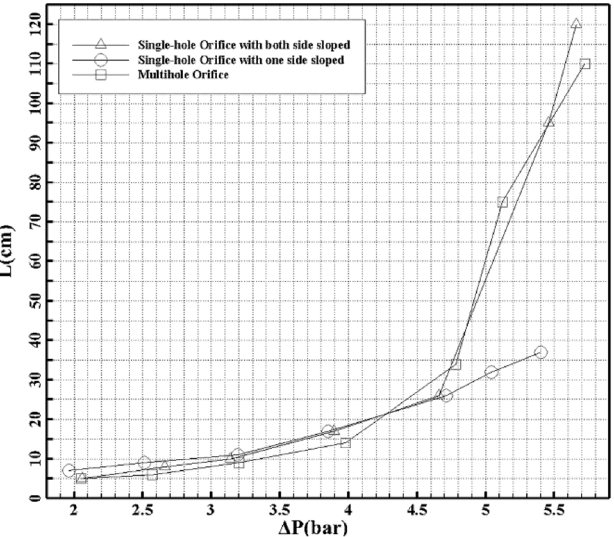
Fig. 11. Comparison of the trends of cavitation length against pressure difference across a multi-hole ori fi ce, a single-hole ori fi ce with a two-sided sloped edge and a single-hole ori fi ce with a one- sided sloped edge.